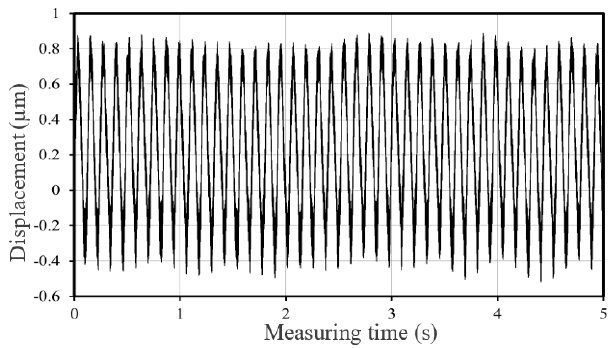
Figure 10. Axial error measurement of a spindle at a 500 rpm rotation speed.